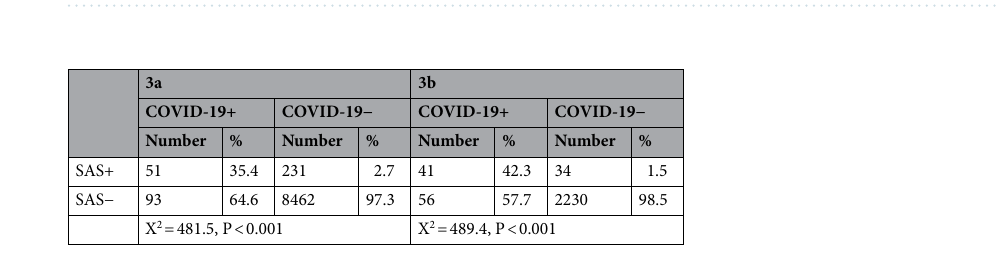
Table 3. Cross tabulation table for COVID-19 and SAS positivity (3a: all age, 3b: 20